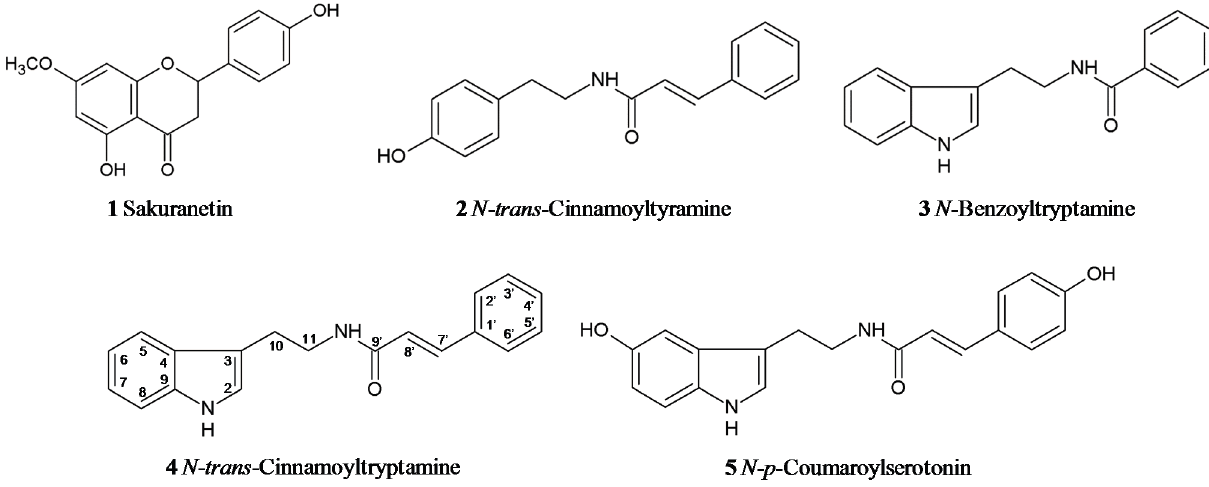
Figure 2. Structure of phenylamides isolated from UV-treated rice leaves. Compounds 4 and 5 were isolated from UV-treated rice leaves and identified as N - trans -cinnamoyltryptamine and N - p -coumaroylserotonin using NMR and MS analysis, respectively. Compounds 2 and 3 were previously identified as N - trans -cinnamoyltyramine and N -benzoyltryptamine, respectively